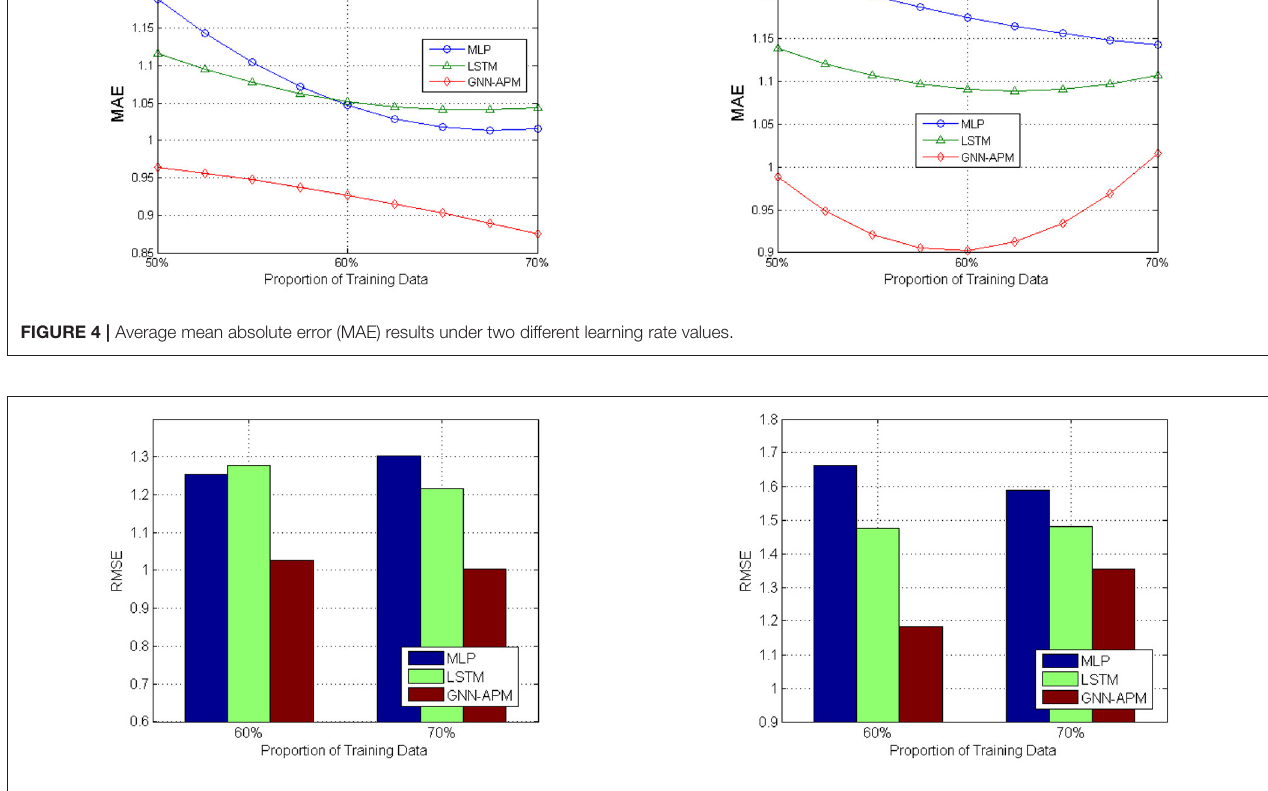
FIGURE 5 | Average RMSE results under two different learning rate values.